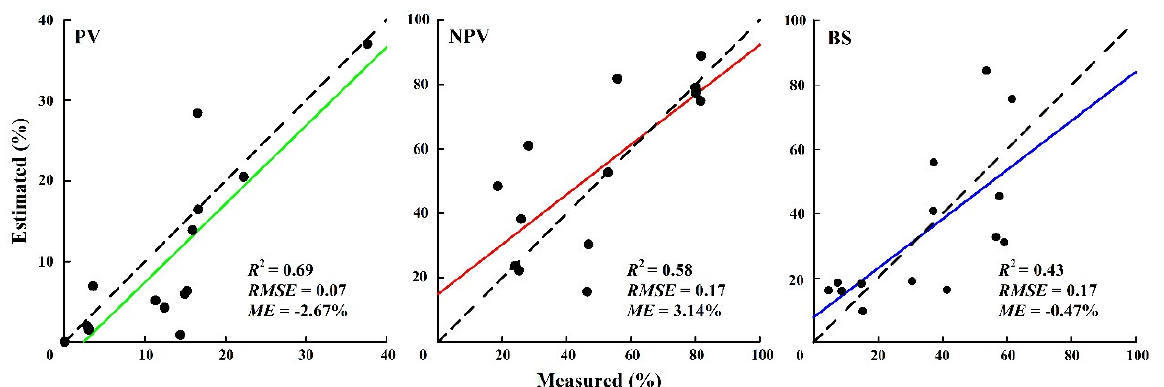
Figure 9. Estimating the accuracy of the f PV , f NPV and f BS from the field measurements. The dotted line represents the 1:1 reference line. The green, red and blue solid lines denote the fitted lines of the PV, NPV and BS,